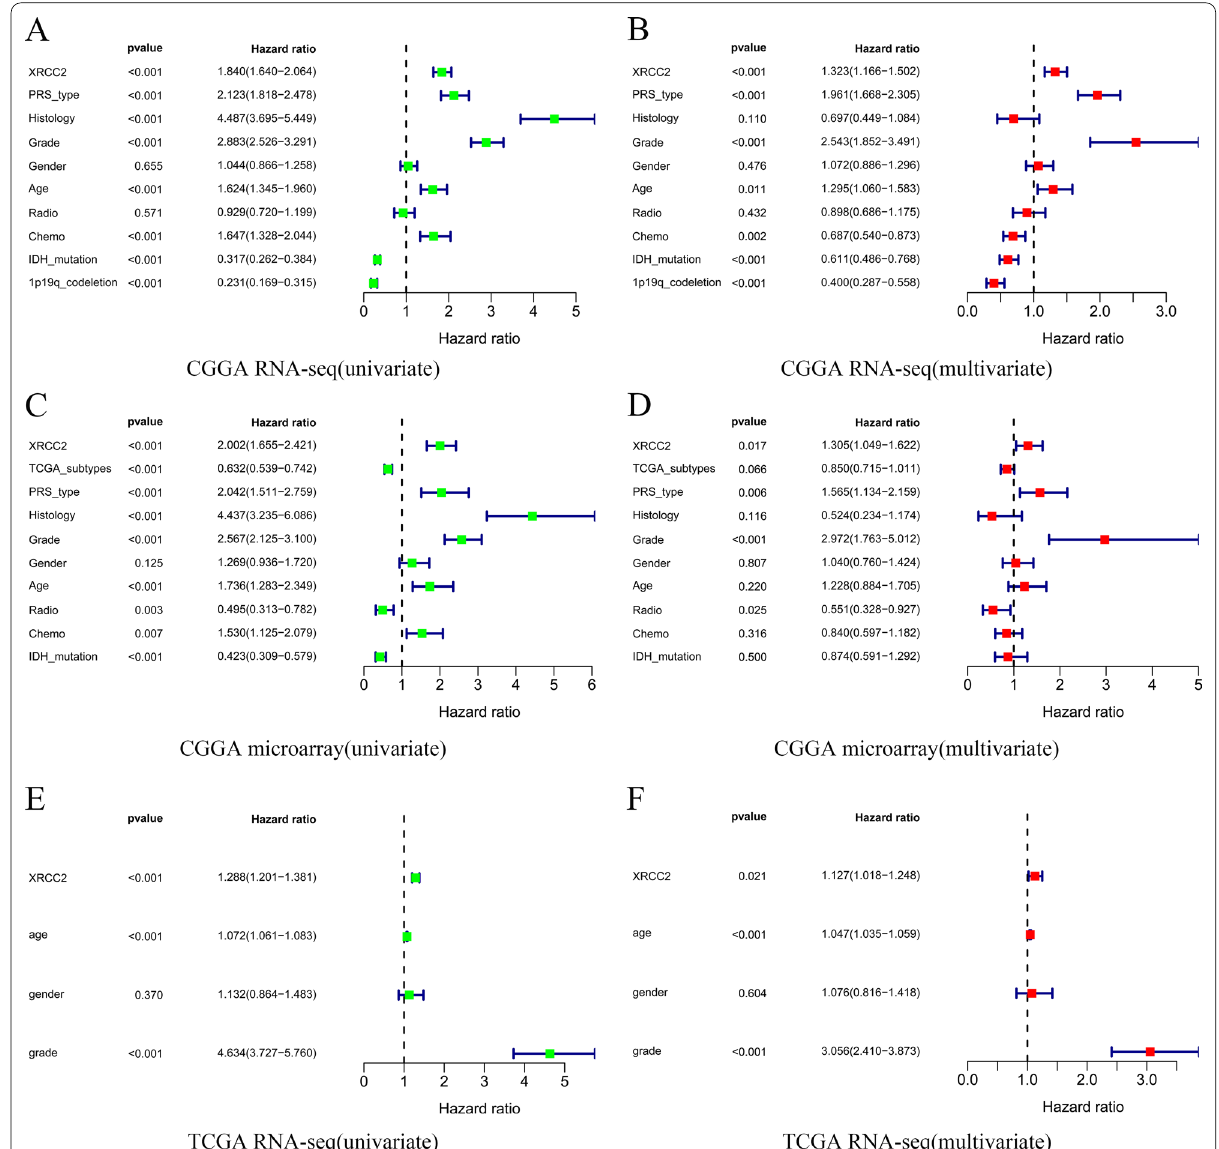
Fig. 3 XRCC2 is an independent risk factor for poor glioma prognosis. A , C , E Results of the univariate analysis based on CGGA RNA-seq, CGGA microarray, and TCGA RNA-seq, respectively; B , D , F Results of the multivariate analysis based on CGGA RNA-seq, CGGA microarray, and TCGA RNA-seq, respectively. CGGA Chinese Glioma Genome Atlas; TCGA The Cancer Genome